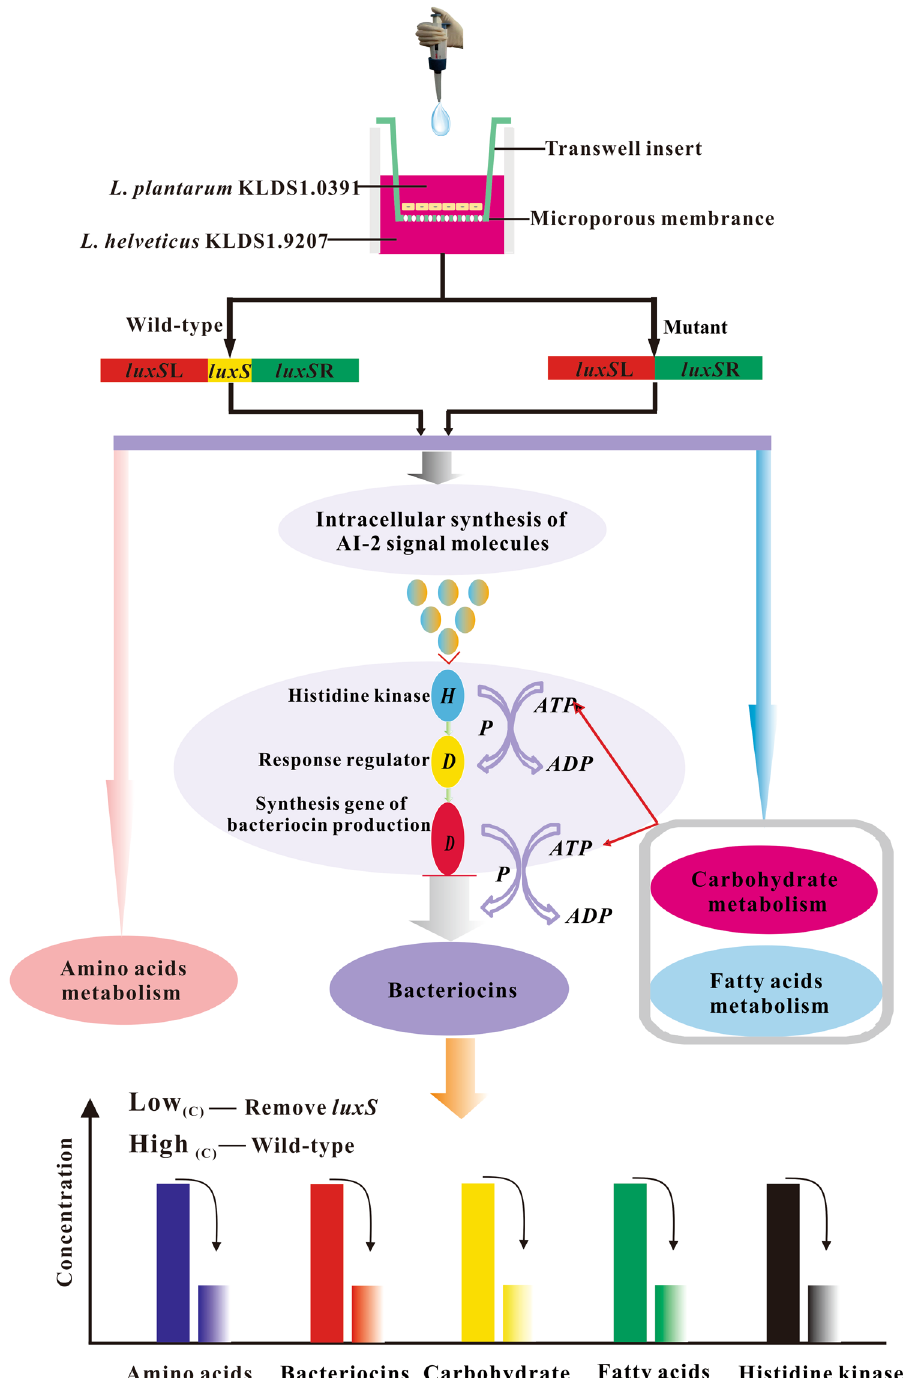
Figure 6. Possible mechanism of LuxS in bacteriocin biosynthesis by L. plantarum KLDS1.0391 in co- cultivation with L. helveticus KLDS1.9207. luxS L (1100 bp) and luxS R (1100 bp) represent the conserved left and right domains, respectively, of luxS